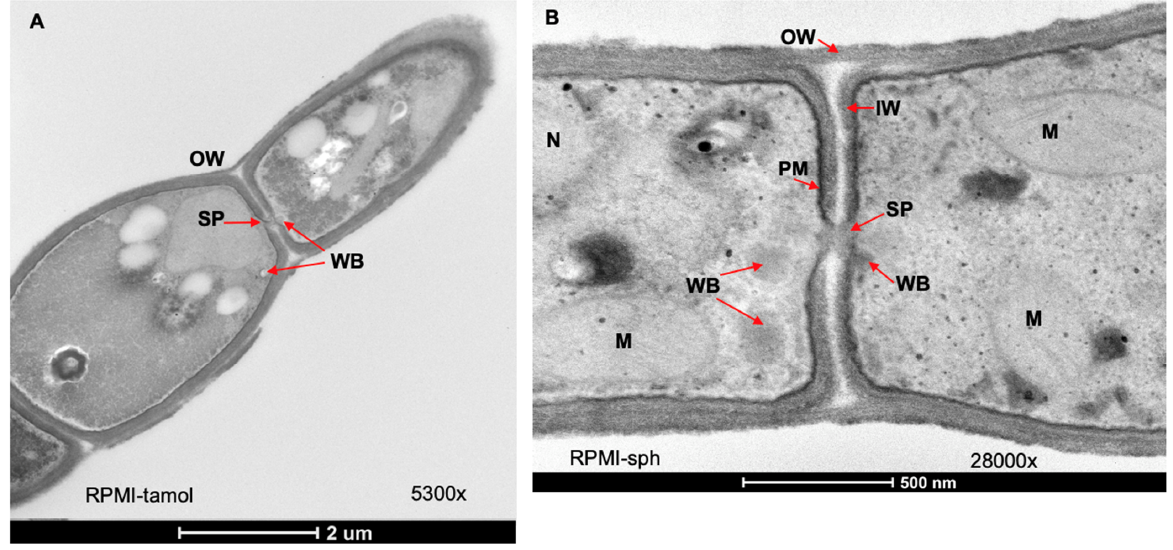
Figure 6. Hallmarks of mycelia observed in the mycelial form of C. posadasii S/E strain. TEM images of C. posadasii S/E strain following 168 h growth in RPMI-tamol ( A ) or RPMI-sph media ( B ) SP: septal pore; WB: Woronin bodies; OW: outer wall; IW: inner wall; PM: plasma membrane; M: mitochondria; and N: nucleus.